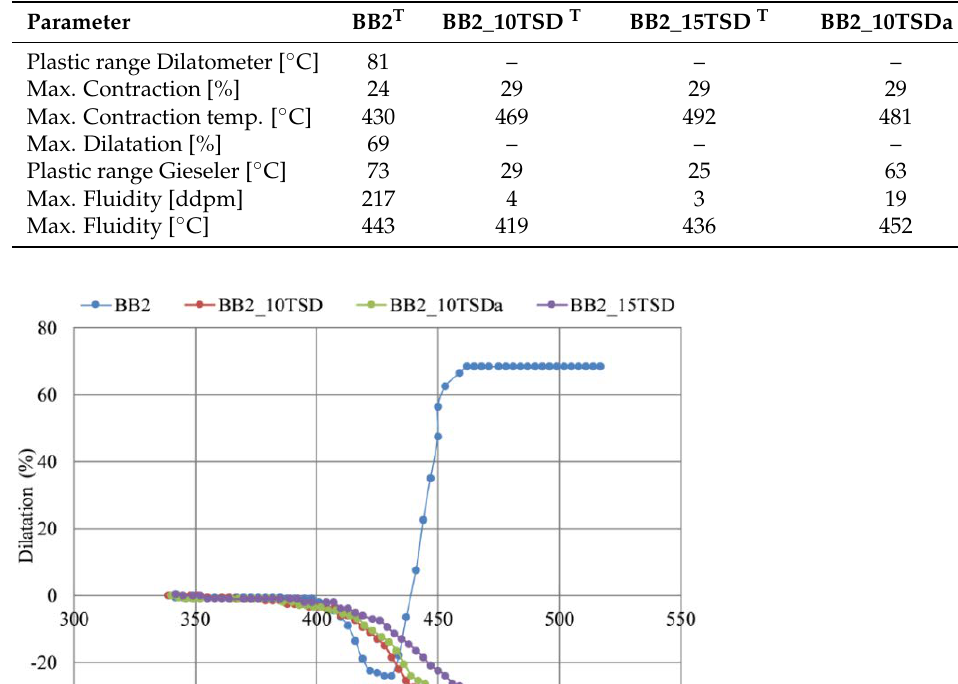
Table 4. Dilatometer and Gieseler test data for the coal blends before carbonization in technical scale at DMT. All blends contain HV2 coal, i.e., BB2 T .